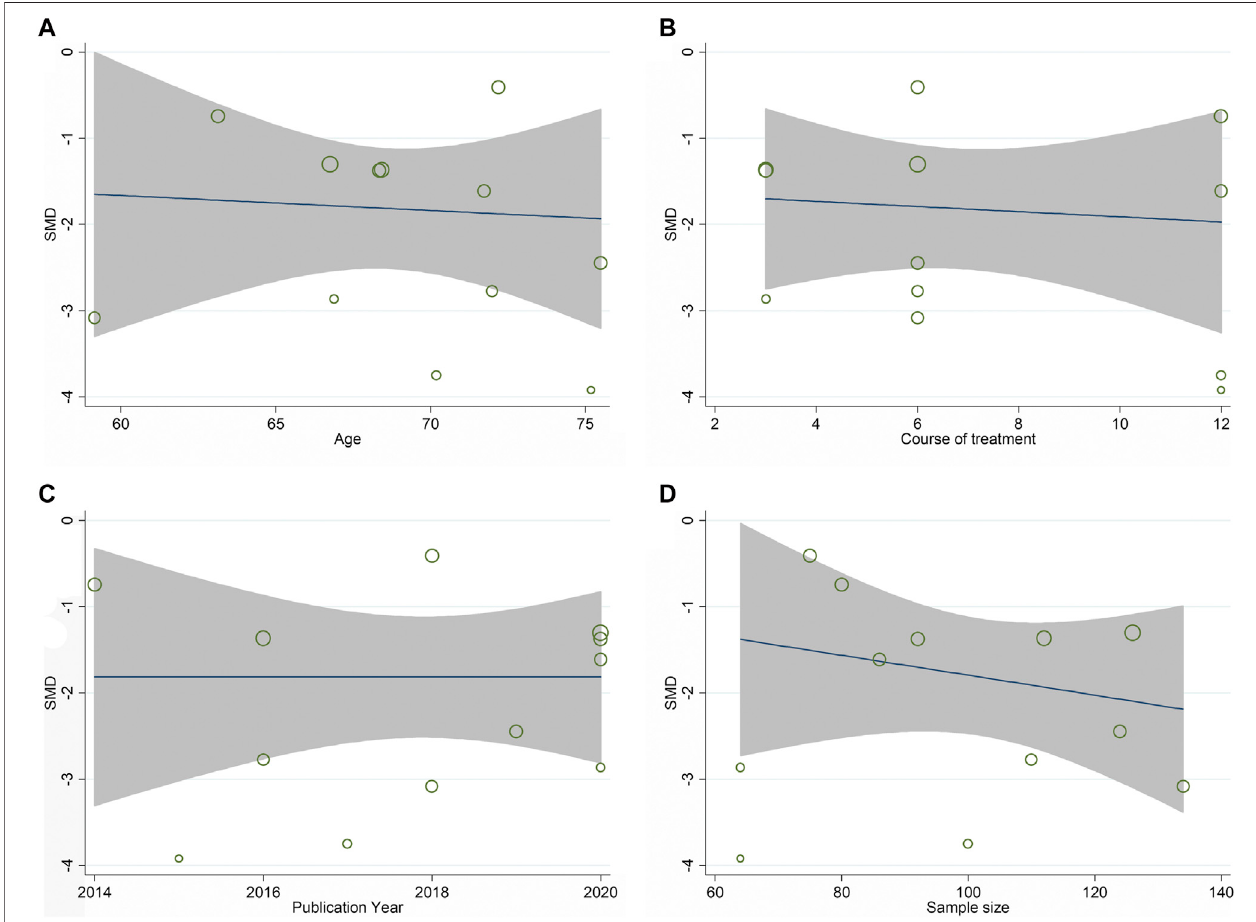
FIGURE 4 | Meta-regression analysis of ALP: (A) Age (B) Course of treatment (C) Publication year (D) Sample size.